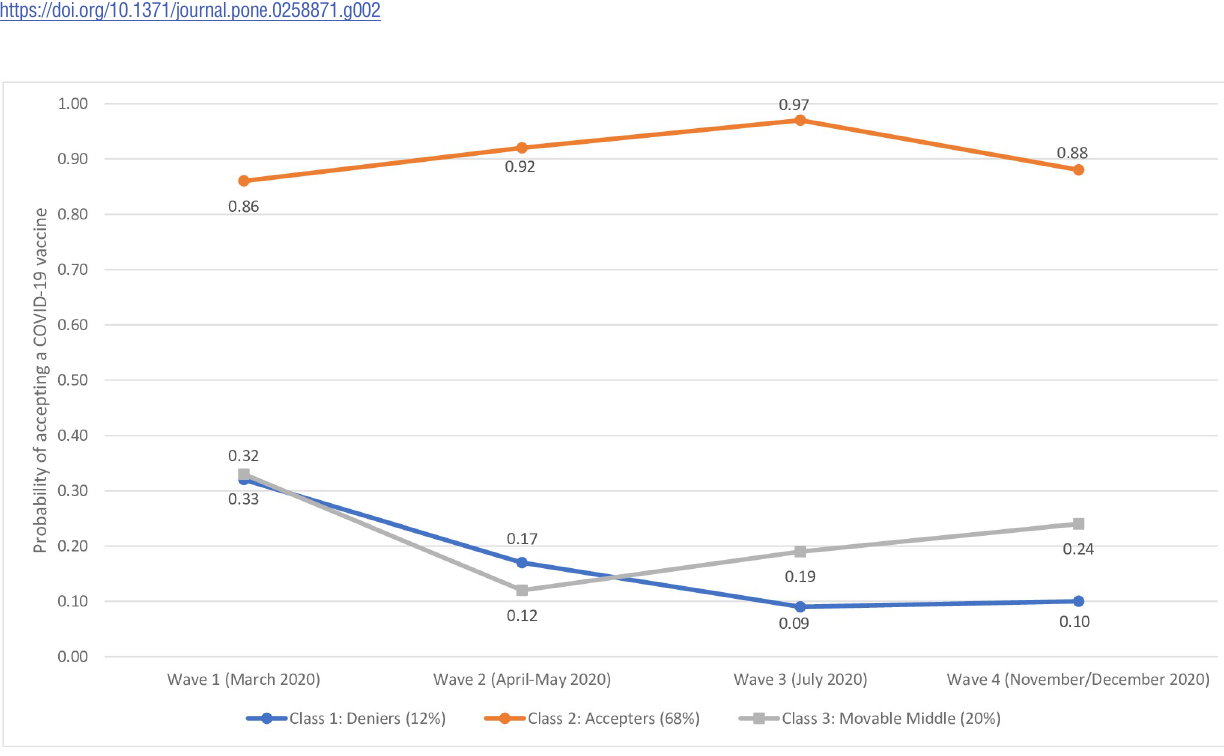
PLOS ONE | https://doi.org/10.1371/journal.pone.0258871 November3, 2021 12 /